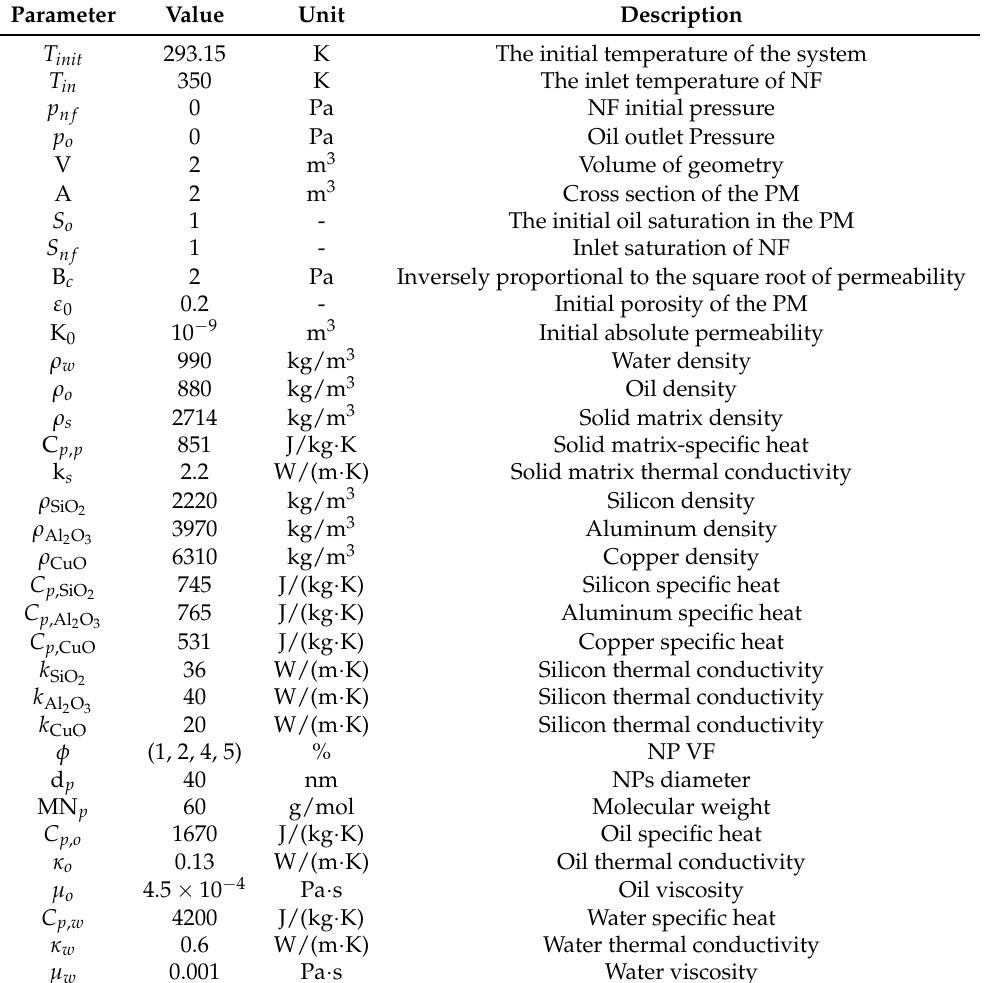
Figure 1. The flow chart of the mathematical model. Table 2. Model parameters for the simulation of NF flooding in the PM for